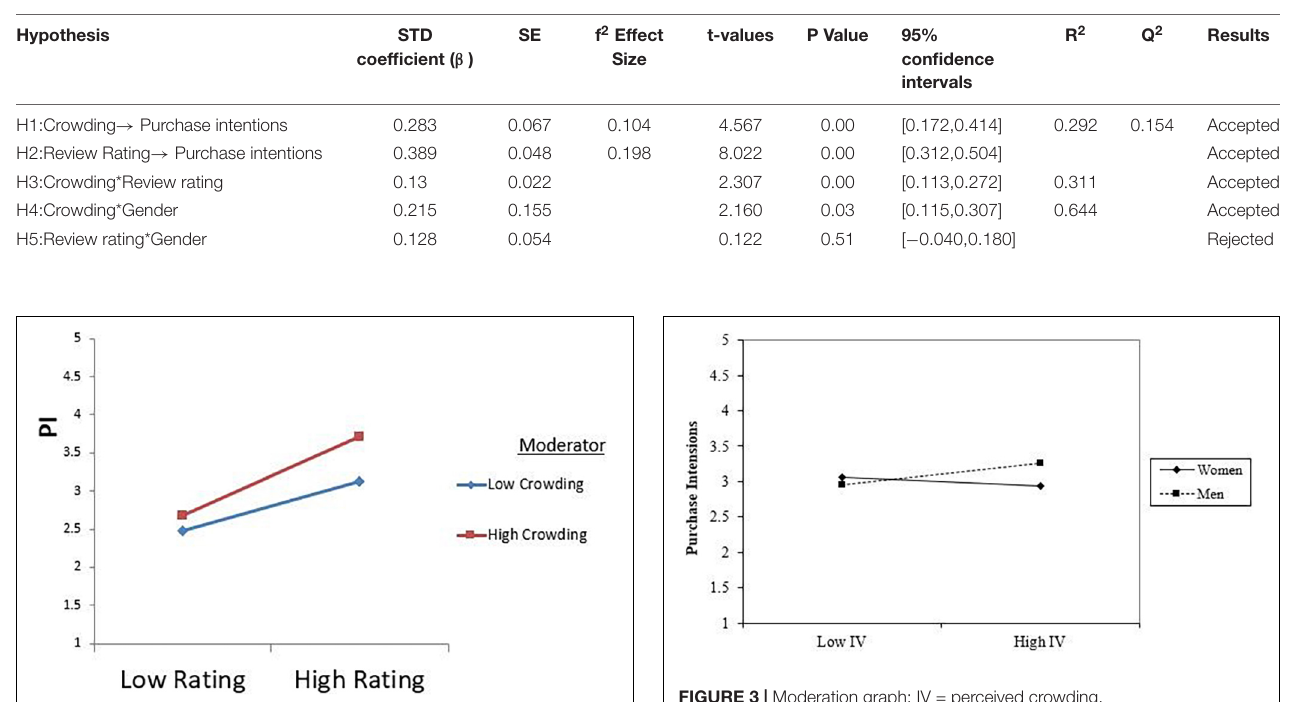
TABLE 5 | Structural model assessment.